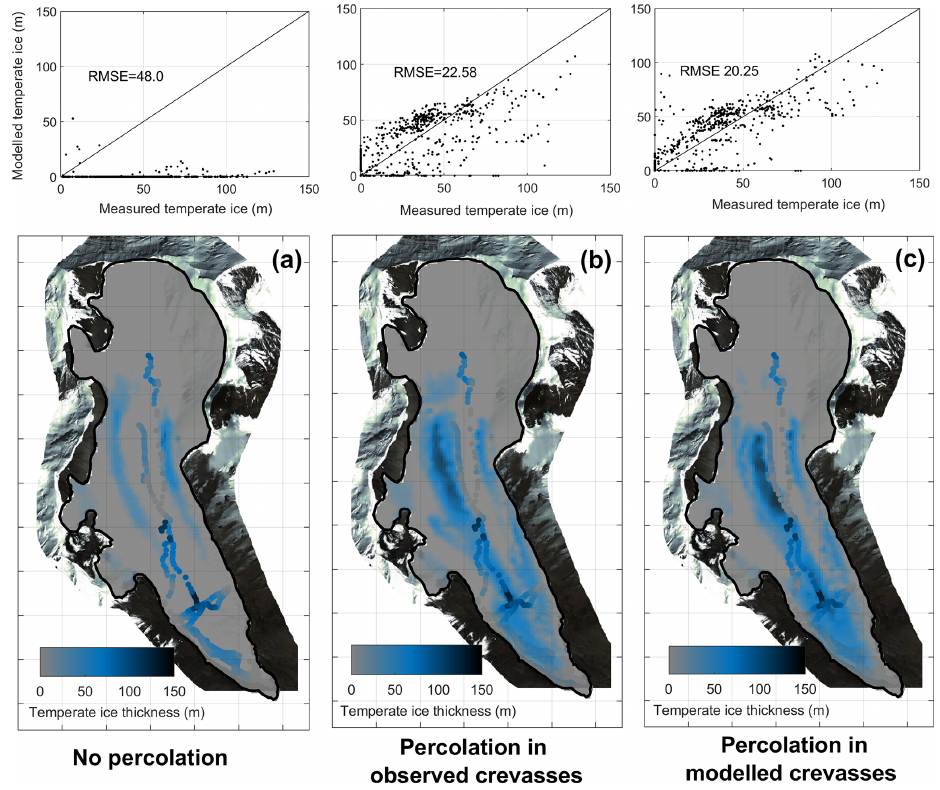
Figure 8. Modelled vs. measured temperate ice thicknesses (upper panels) and comparison between model (colour background) and mea- surements (dots) (lower panels): (a) without crevasse influence, (b) with water percolation in observed crevassed areas and (c) with water percolation in modelled crevassed